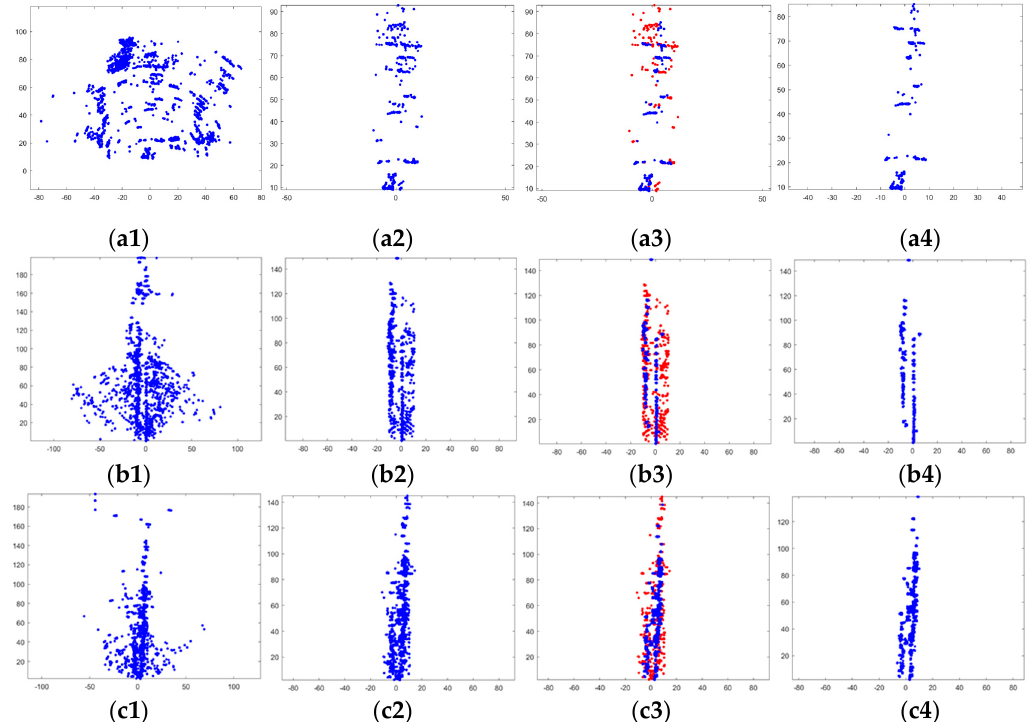
Figure 11. The three groups of pictures ( a – c ) correspond to three scenes. ( a1 – c1 ) A point cloud map combining 20 frames of original data; ( a2 – c2 ) A point cloud map after filtering out low-precision points; ( a3 – c3 ) An effect map of DBSCAN identifying outliers, in which the red points are outliers; ( a4 – c4 ) Point cloud after filtering out outliers. The vertical direction is the y-axis, and the horizontal direction is the x-axis.